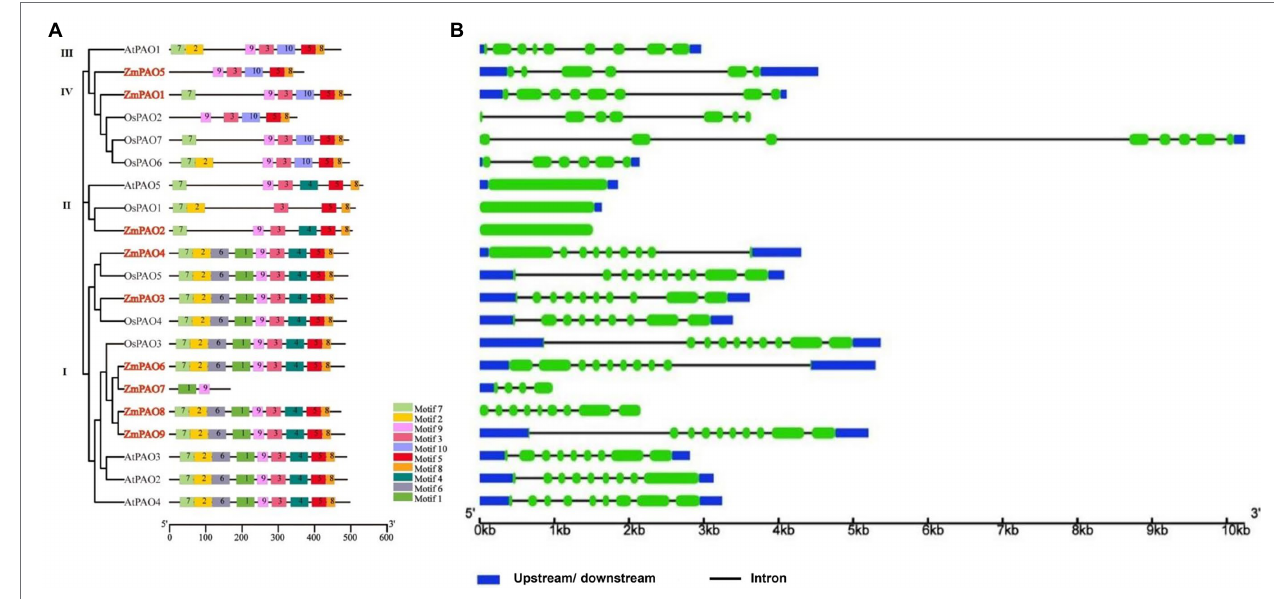
FIGURE 3 | Conserved motifs of PAO proteins and gene structure of PAO genes in maize, rice and Arabidopsis . (A) Distribution of all motifs in maize, rice and Arabidopsis were identified by MEME. Different motifs are indicated in various colored boxes. (B) Exon/intron structures of PAO genes in maize, rice and Arabidopsis . Exons are indicated with green boxes, and introns are shown as black lines. The upstream/downstream region of PAO genes are indicated in blue boxes. The length of each PAO gene inferred by the scale at the